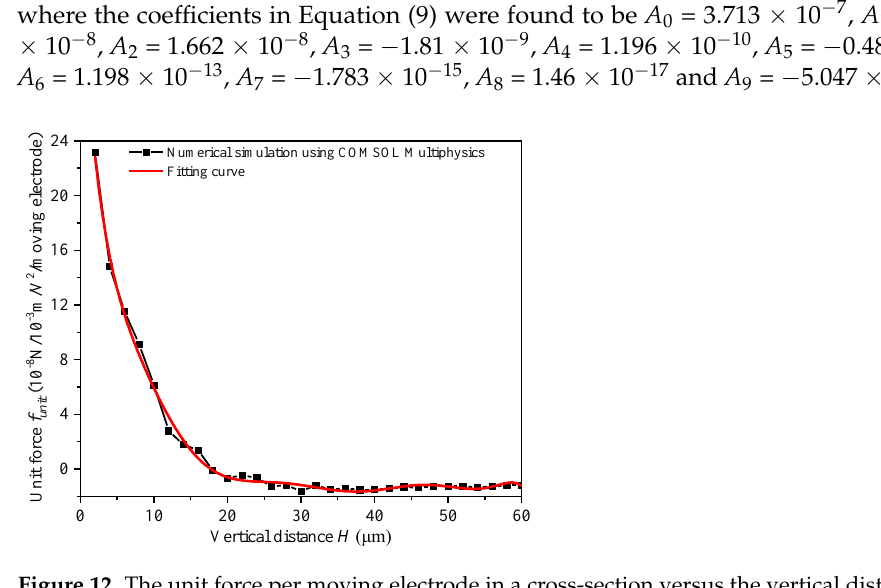
Figure 12. The unit force per moving electrode in a cross-section versus the vertical distance.